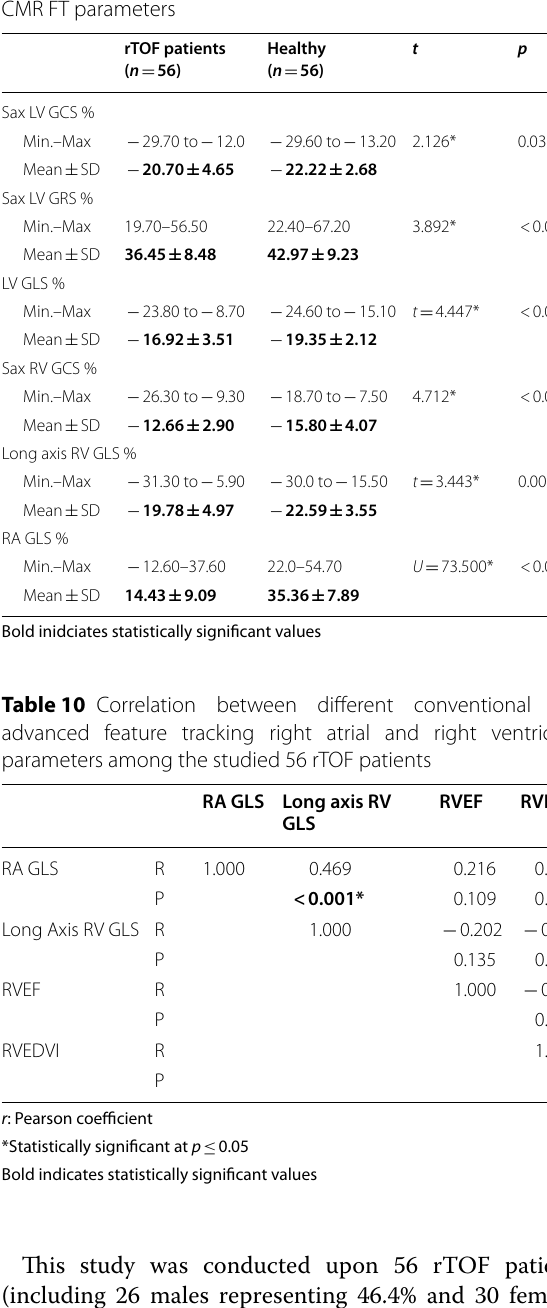
Table 11 Comparison between patients with RVOTO and without RVOTO among 56 rTOF patients regarding CMR RV